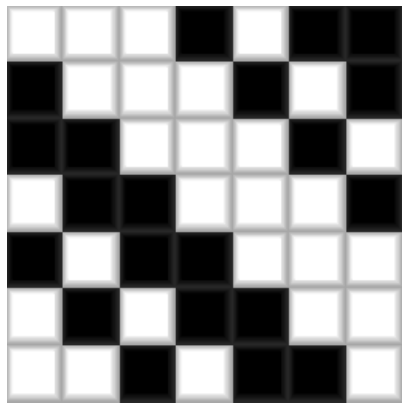
Figure 1: Orthogonal matrices for order 7: Balonin-Sergeev Family: CM(7,2, ω ) CM(7,2, ω )